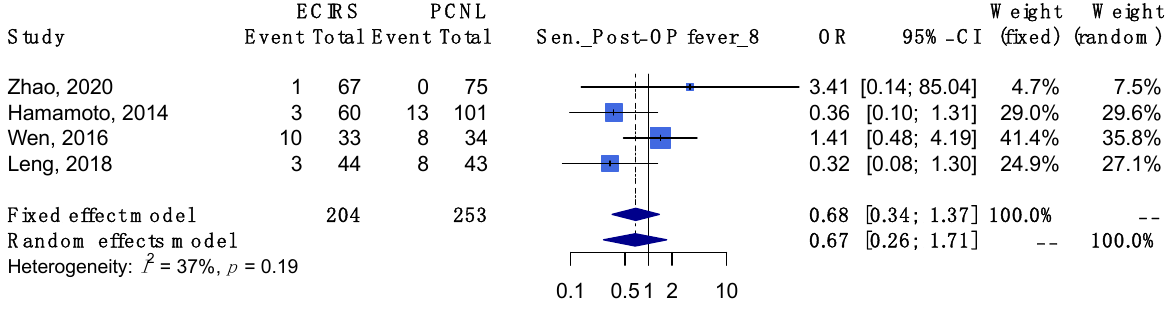
Figure A32. Sensitivity analysis of outcome regarding post-operative fever. ([17–19,22]).